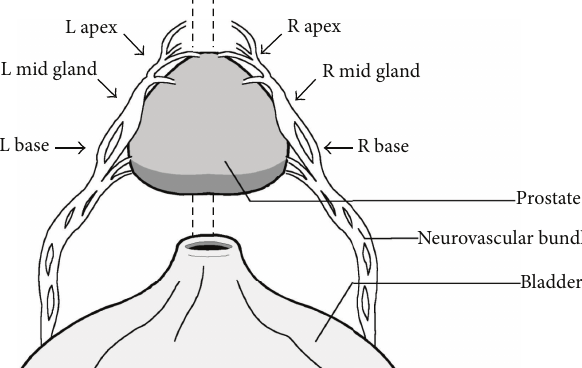
Figure 2: Diagram of neurovascular bundle and points assessed with LDU